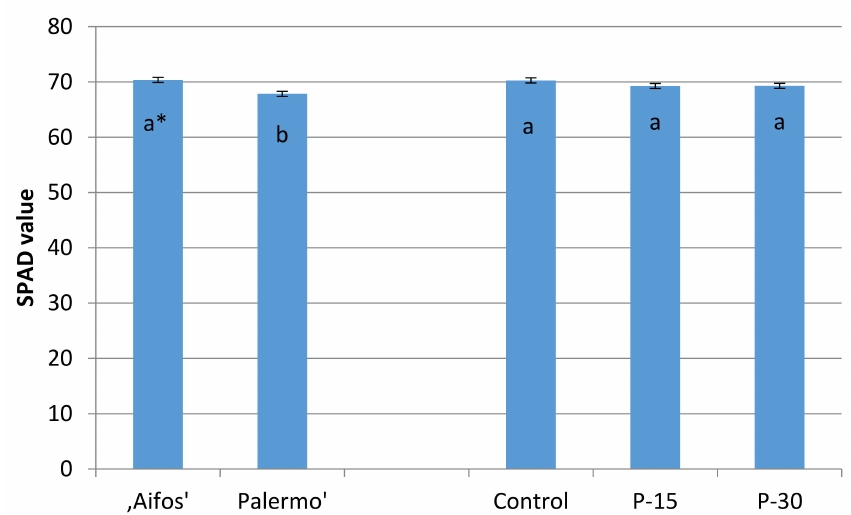
Figure 1. E ff ect of fertilizer with polyphosphates in hydroponic cultivation and cultivar of pepper on the chlorophyll index in pepper leaves (average of two terms). * The mean values marked with the same letters do not di ff er significantly according to the Tukey HSD test at α = 0.05.